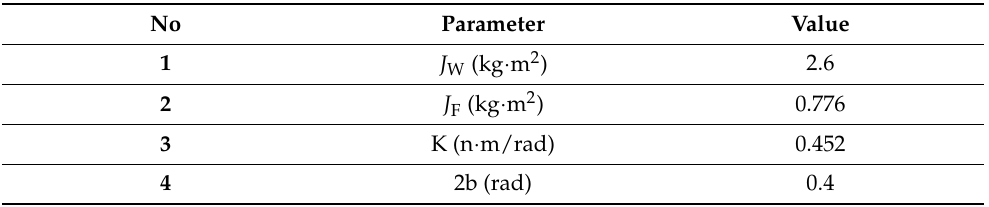
Table 1. Parameters of the experimental simulation.